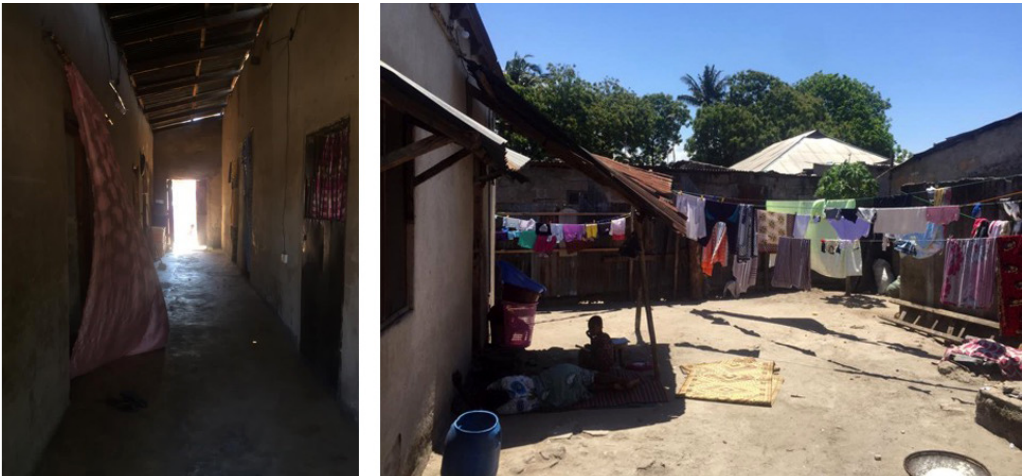
Figure 4. Core elements of the Swahili house: The central corridor provides structure, connectivity, and thermal com‐ fort; the courtyard offers privacy in an open space, in contrast to the public front veranda. Source: Courtesy of Beatrice Mahagama and Leticia